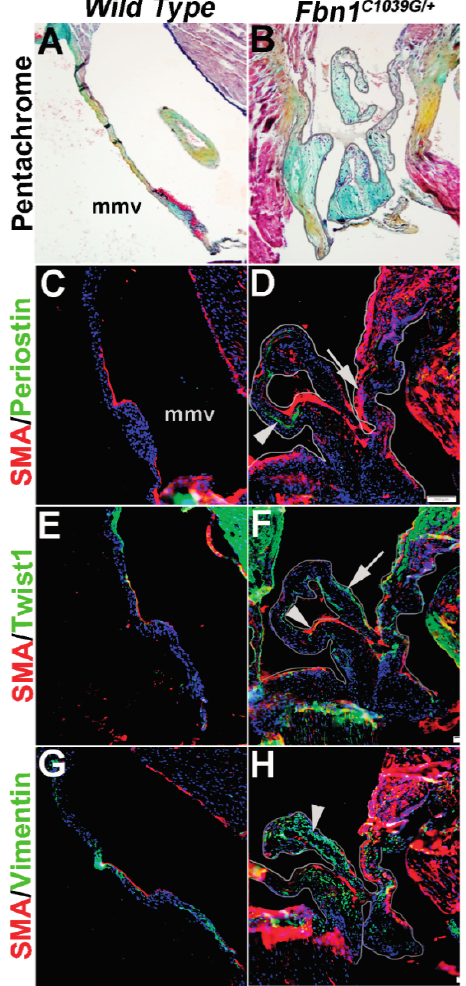
Figure 7. Characterization of VIC phenotypes in diseased mitral valves from 12 month old Fbn1 C1039/+ mice. Pentachrome staining to show extracellular matrix composition and organization in 12 month wild type ( Fbn1 +/+ mice) ( A ) and Fbn1 C1039/+ ( B ) mice. ( C – H ) Immunohistochemistry to detect expression of smooth muscle α -actin (SMA) with Periostin ( C , D ), Twist1 ( E , F ) and Vimentin ( G , H ) in cells within the mitral valve leaflet of wild type ( C , E , G ) and Fbn1 C1039/+ ( D , F , H ) mice. Arrows indicate SMA expression (red) and arrowheads indicate Periostin ( C , D ), Twist1 ( E , F ) and Vimentin ( G , H ) shown in green. mmv, mural mitral